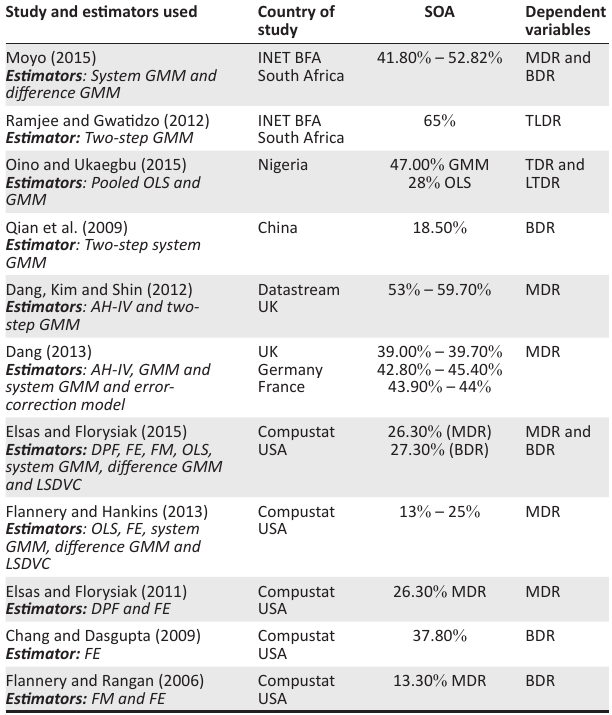
TABLE 1: Some empirical estimates of speed of adjustment leverage forwards target leverage. Study and estimators used Country of